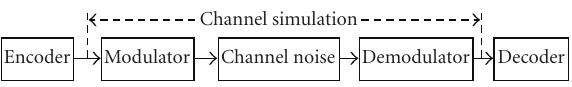
Figure 3: Experiment